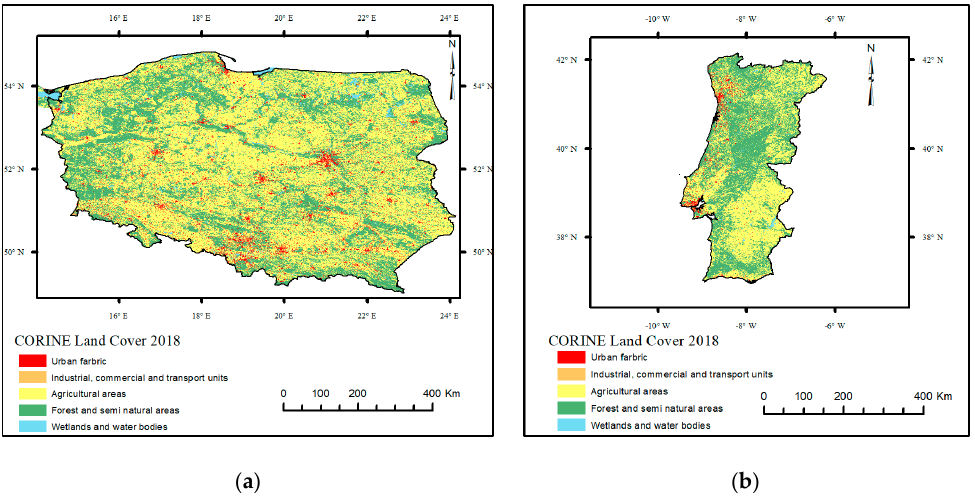
Figure 2. CORINE land cover data for ( a ) Poland and ( b ) Portugal.